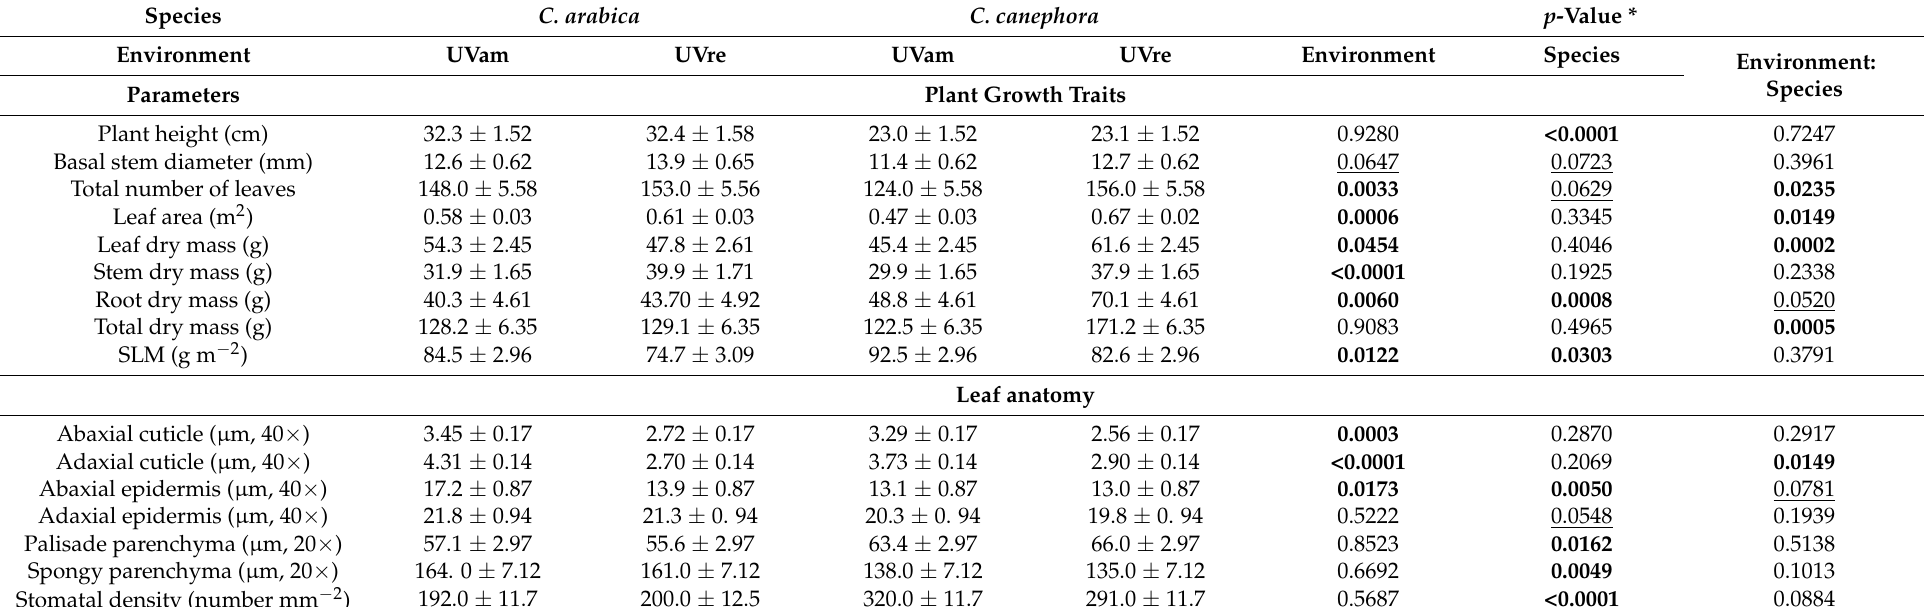
Table 1. Plant growth traits and leaf anatomy parameters of Coffea arabica and C. canephora under near ambient (UVam) or reduced (UVre) ultraviolet levels. Mean values ± S.E. (n = 8 or 5) and ANOVA p -Values are